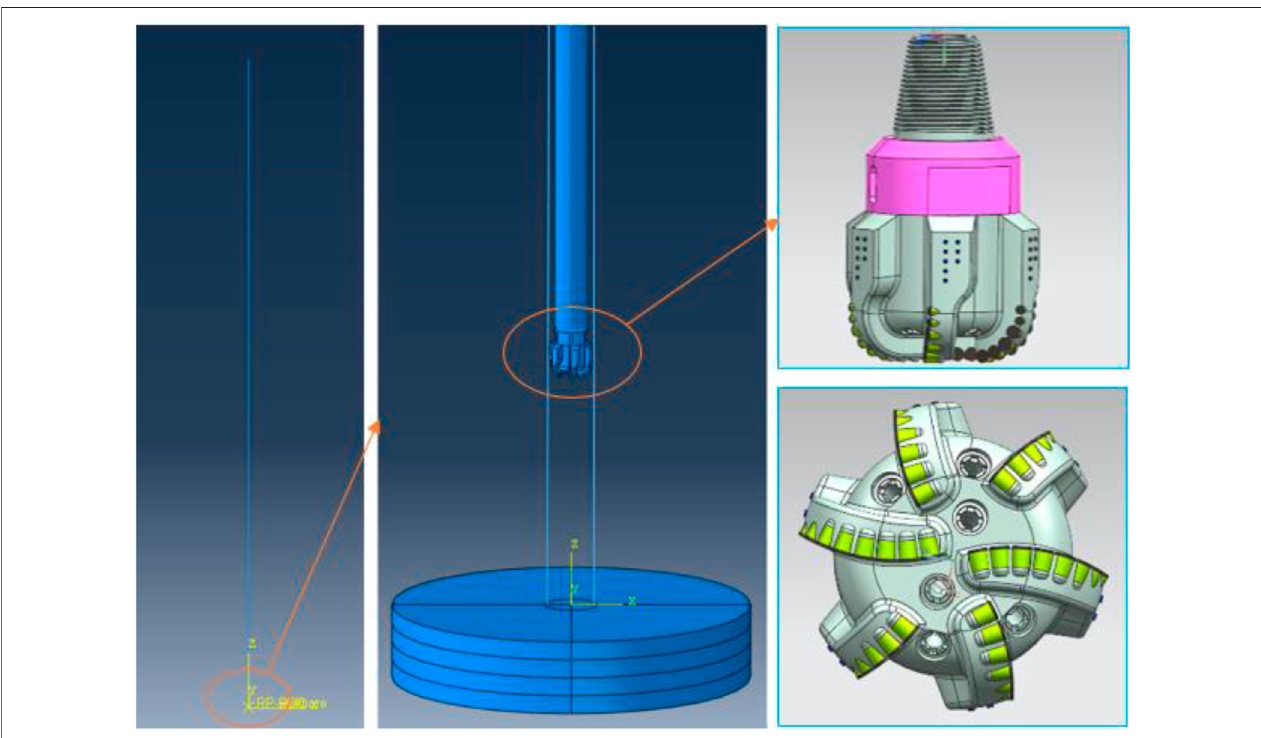
FIGURE 2 | Geometric model of FEM.